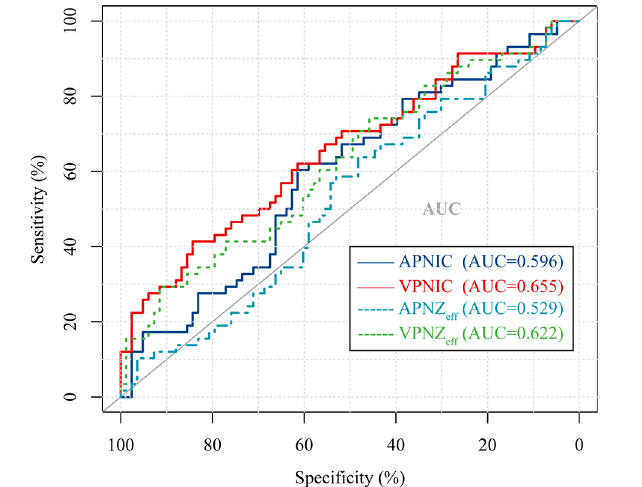
et al. (25) showed that most rectal cancer metastatic lymph nodes are located in the mesorectum close to the tumor and along the superior rectal artery. Therefore, the area de fi ned in this study was suf fi cient to include metastatic lymph nodes. 3. Another